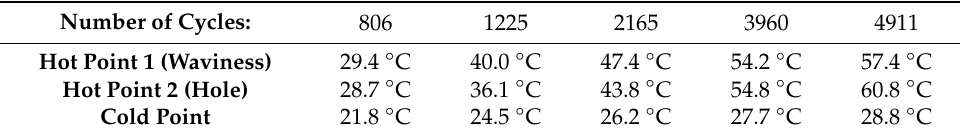
Table 2. Surface temperature for control points of the specimen cut in transversal direction with geometry